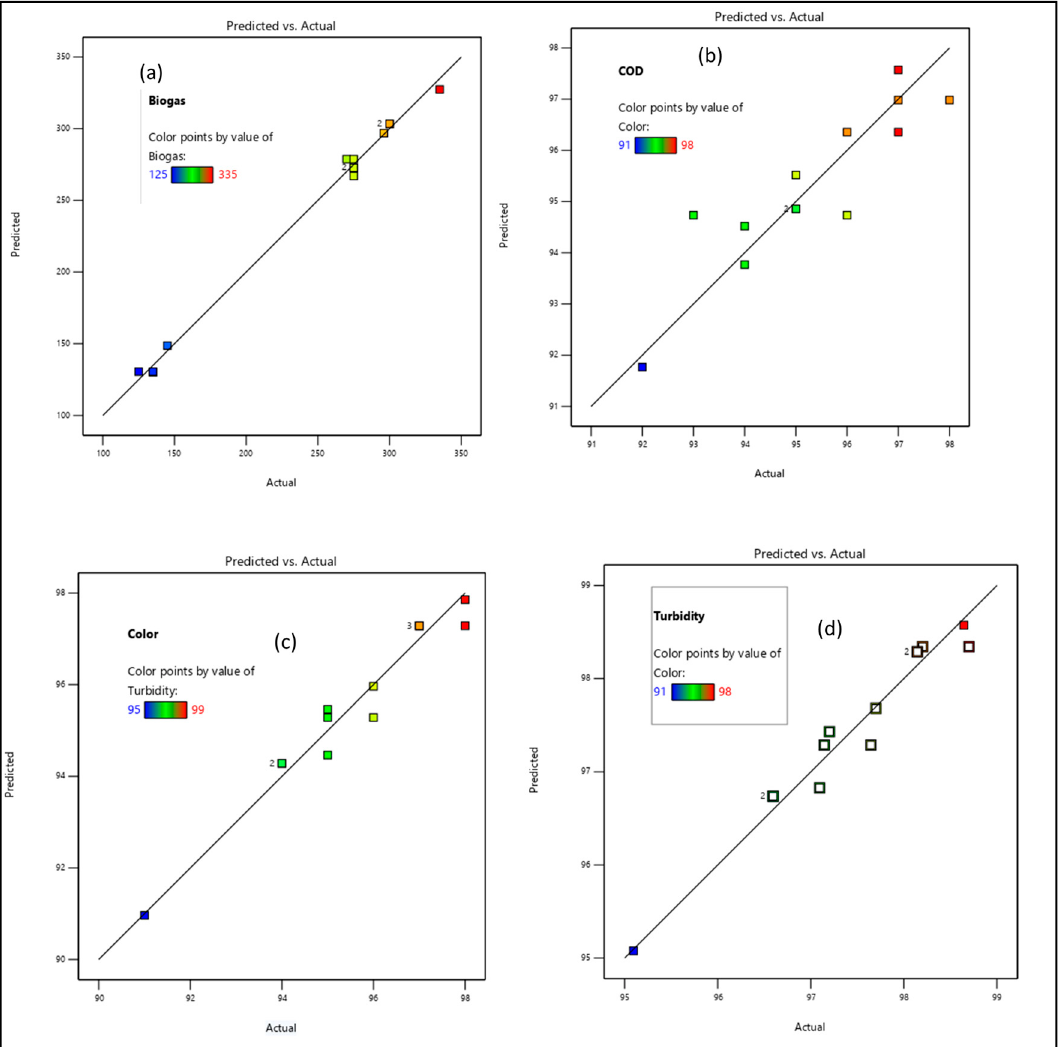
Figure 5. Diagnostic experimental plots against the modified RSM-BBD predicted results; ( a ) biogas, ( b ) COD, ( c ) color, and ( d ) turbidity. (The numbers on the diagonal line are the data points attained at a specific conditions of the experimental runs as inferred in Table